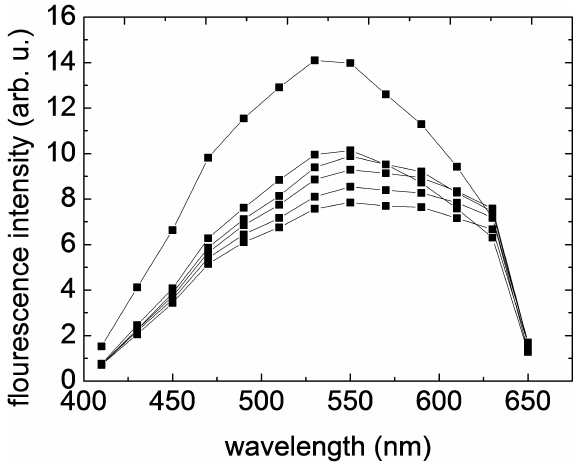
Figure 2: Luminescence spectrum in the range 420 to 650 nm of gold particles on glass as measured by the confocal microscope CLSM with 700 nm pulsed (140 fs) excitation light at times 1, 4, 8, 12, 16 and 20 s. At each consecutive spectrum the intensity de- creases and the spectral shape changes. At 650 nm a cut off filter was used.